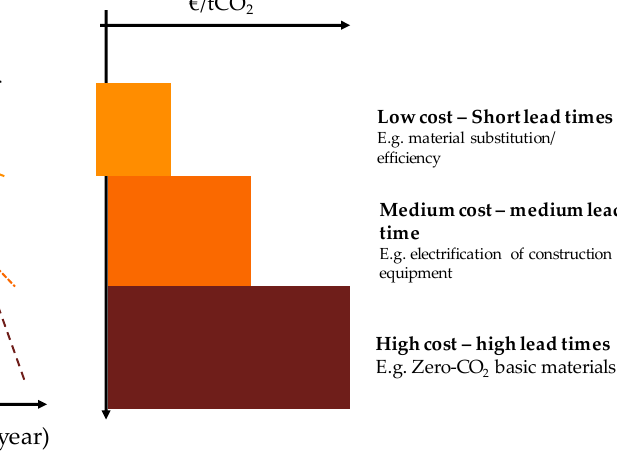
Figure 10. Successful decarbonization of the supply chains for buildings and infrastructure in less than three decades will require the parallel pursuit of emission abatement measures with very different characteristics. Figure adapted from Vogt-Schilb and Hallegatte (2014) [160].